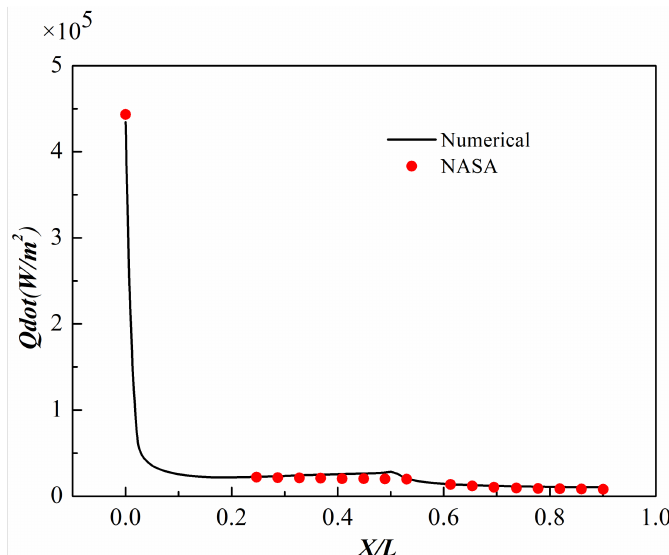
Figure 7. Comparison between blunt biconical numerical results and NASA results.